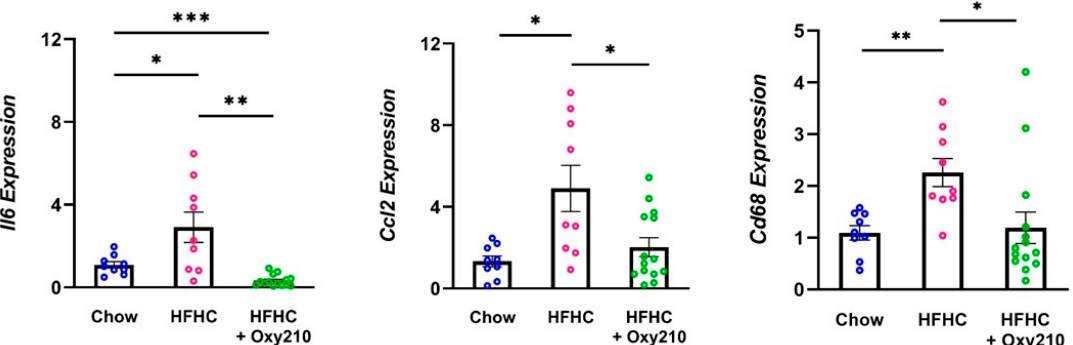
Figure 2. Effects of Oxy210 on pro-inflammatory gene expression in gonadal white adipose tissue. Expression of pro-inflammatory genes, Il6 and Ccl2 , and macrophage marker, Cd68 , in white adipose tissue from control (chow, n = 9), high fat high cholesterol (HFHC, n = 9) and HFHC + Oxy210-fed ( n = 14) mice were measured by Q-RT-PCR and normalized to GAPDH. Relative gene expression levels are presented as the mean ± SD. (* p < 0.05; ** p < 0.01; *** p < 0.001).